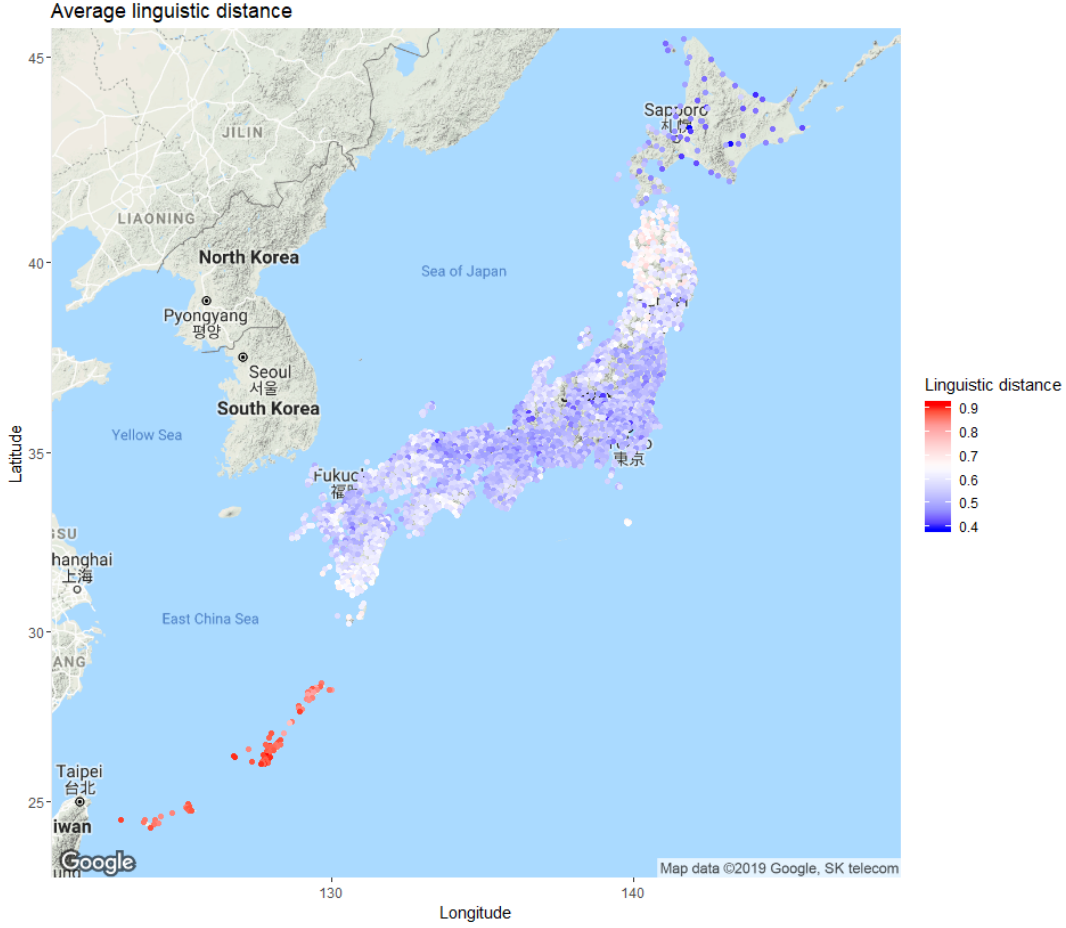
Figure 8. Average linguistic distance map. Colours of each point correspond to the survey location’s average linguistic distance toward all other survey